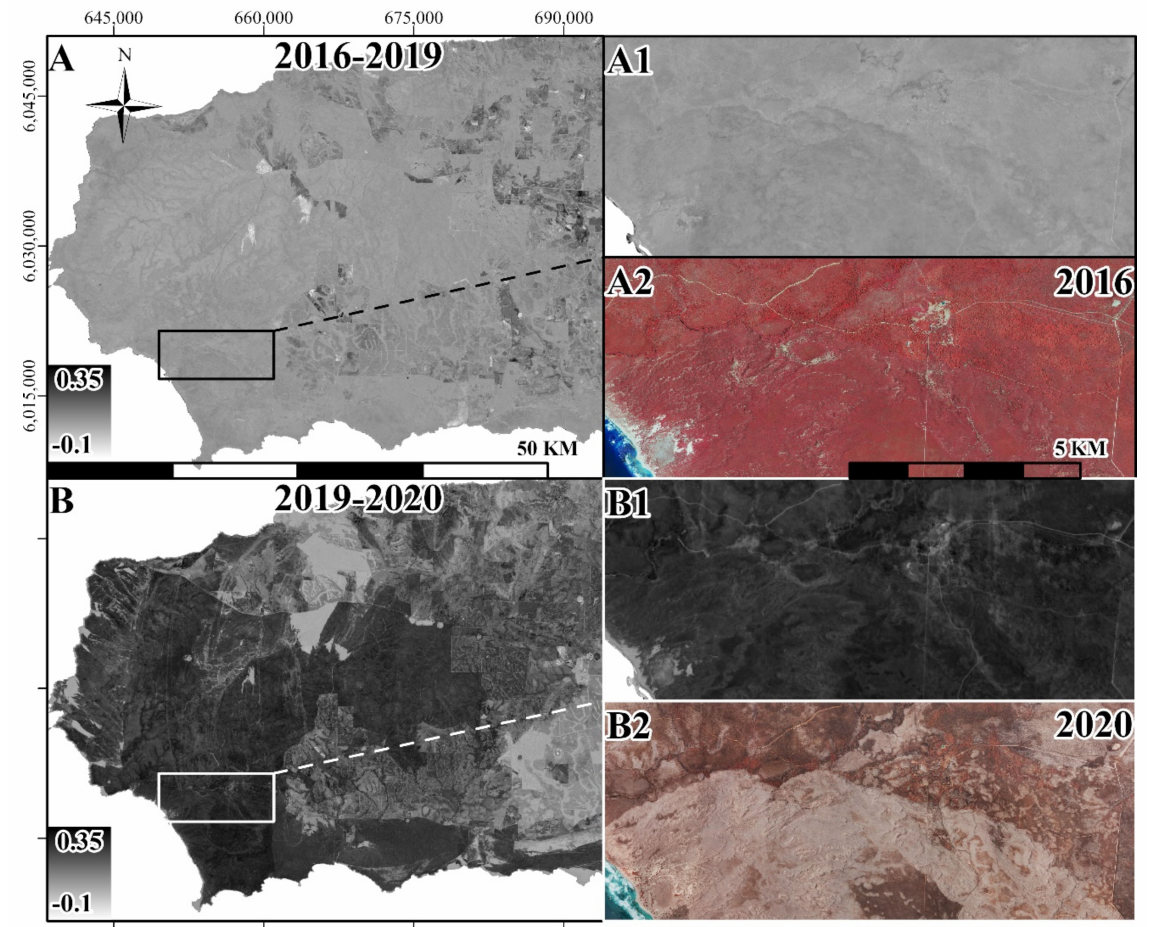
Figure 6. Differenced Disturbance Index taken from Sentinel 2 imagery from December 2016 to December 2019 ( A ) and December 2019 to January 2020 ( B ). Index symbology (white to black) and scale is set from 3 standard deviations of ( B ) image, showing the high burn severity values from the 2019/2020 fires and relatively low dDI values for ( A , A1 ). ( A2 , B2 ) are colour infrared insets of area of ( A1 , B1 ), showing the landscape before and after the